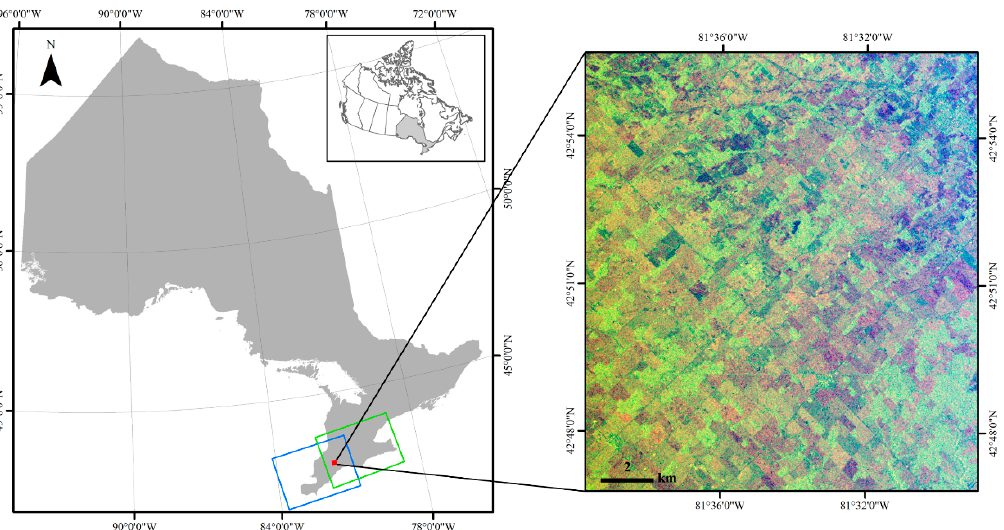
Figure 1. Study area location and Sentinel-1 data. Two Sentinel-1 orbits cover the study area. The green one is orbit number 77 with an incidence angle of 31.5°. The blue one is orbit number 150 with an incidence angle of 41.5°.